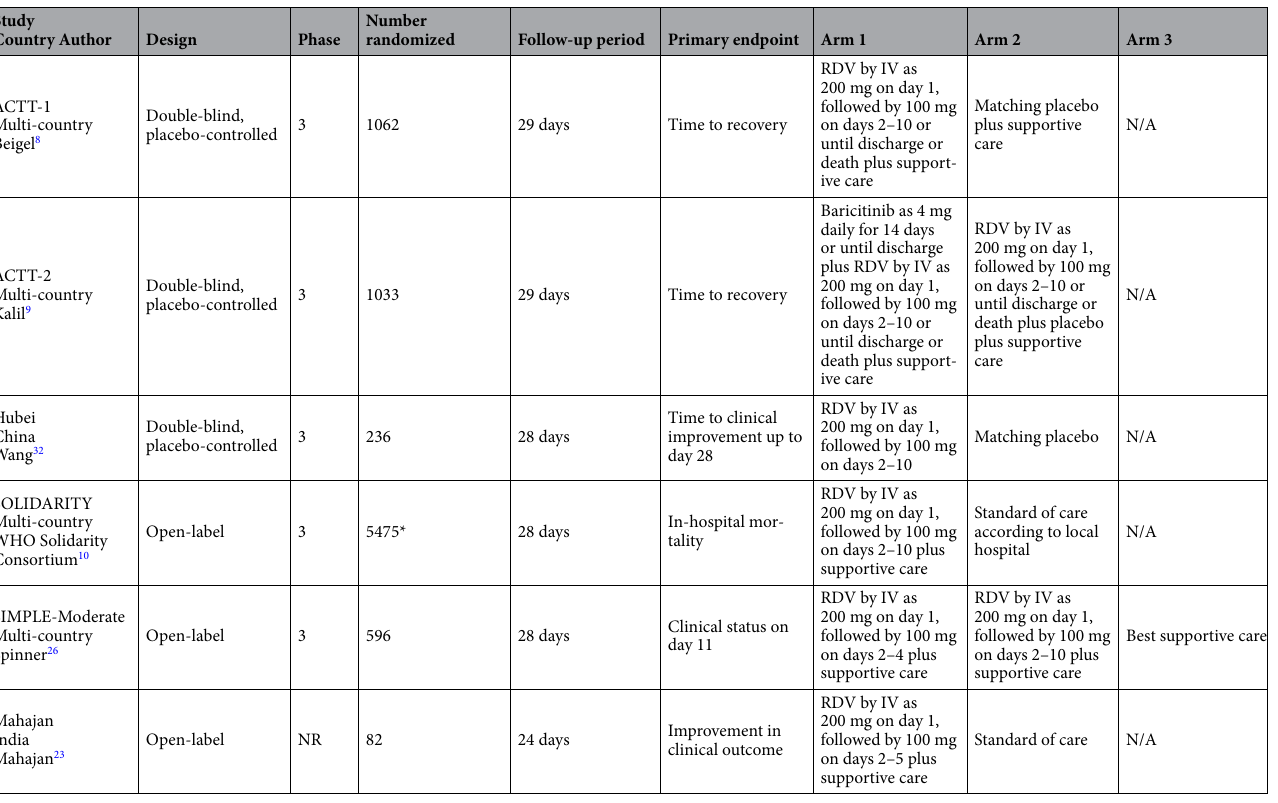
Table 1. Characteristics of randomized controlled trial studies included. *Remdesivir and control arm only. IV Intravenous, N/A Not applicable, NIV Non-invasive ventilation, NR Not reported, RDV